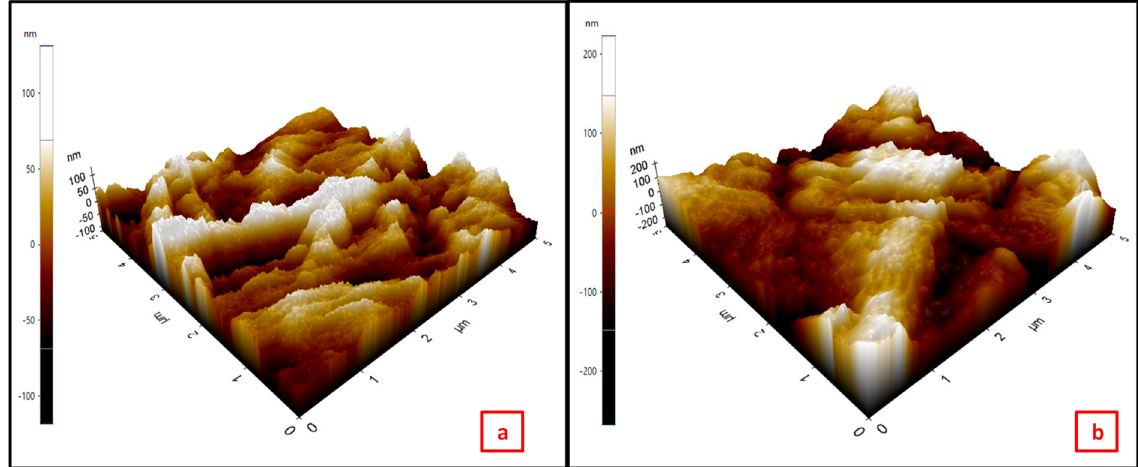
Figure 8. AFM images of the ( a ) unmodified surface and ( b ) ink (cid:3398) modified surface of Whatman no. 4 paper .